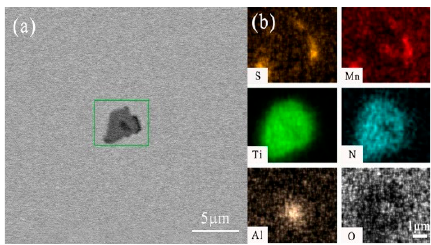
Figure 4. Typical MnS diagrams with Al 2 O 3 and TiN as nucleation cores ( a ) SEM morphology of inclusions; ( b ) composition distribution of inclusions.